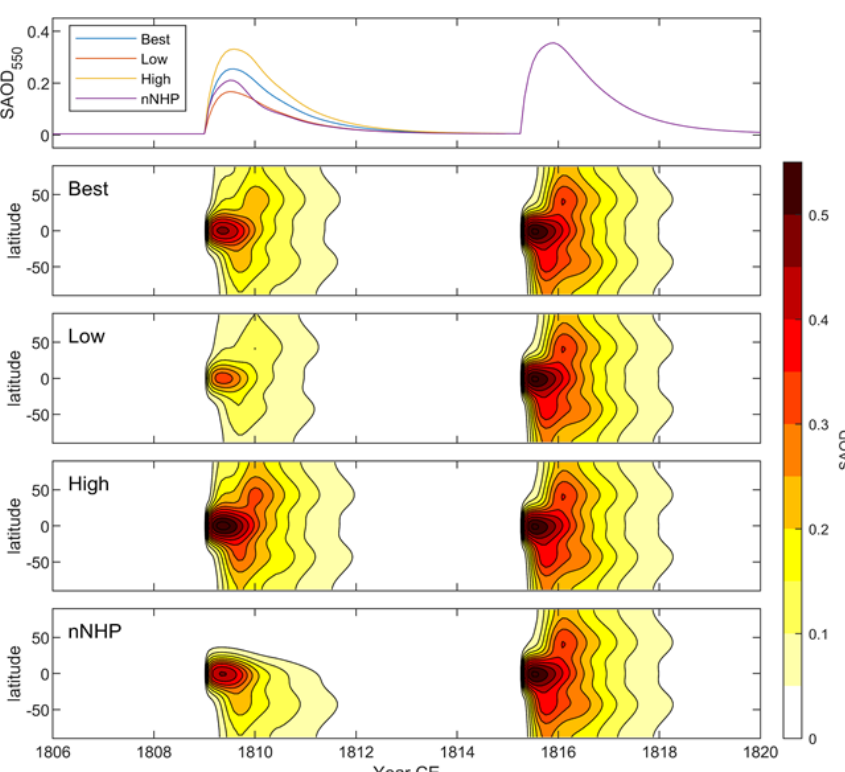
Figure 1. Volcanic radiative forcing. Global stratospheric aerosol optical depth (SAOD) at 0.55µm based on eVolv2k VSSI estimates (Toohey and Sigl, 2017) and calculation with the volcanic forcing generator EVA (Toohey et al., 2016) for the four different forcing scenarios (“Best”, “Low”, “High”, and “nNHP”) for the 1809 eruption and the Best forcing scenario for the Mt. Tambora eruption. Bottom: spatial and temporal distribution of a zonal-mean stratospheric SAOD for the four